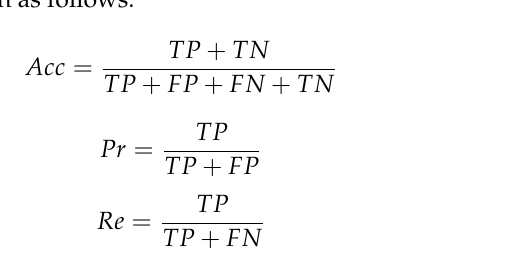
Table 4. LSTM network structure parameters.